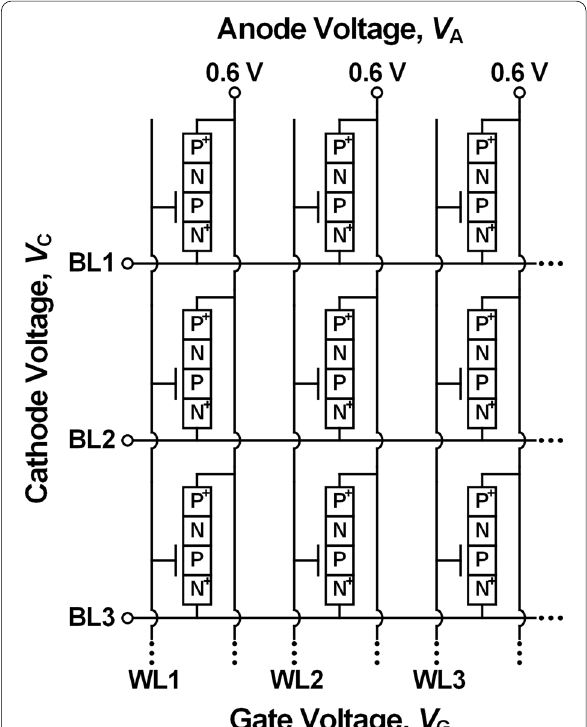
Fig. 5 Schematic diagram of the 3‑T TRAM memory‑cell‑array